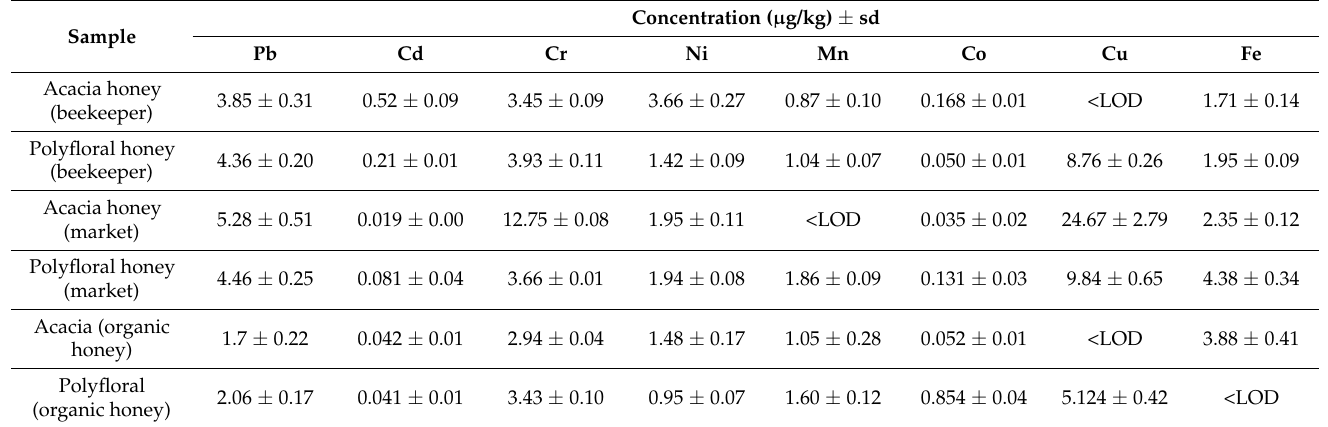
Table 5. Metal concentration in studied samples ( n = 3).